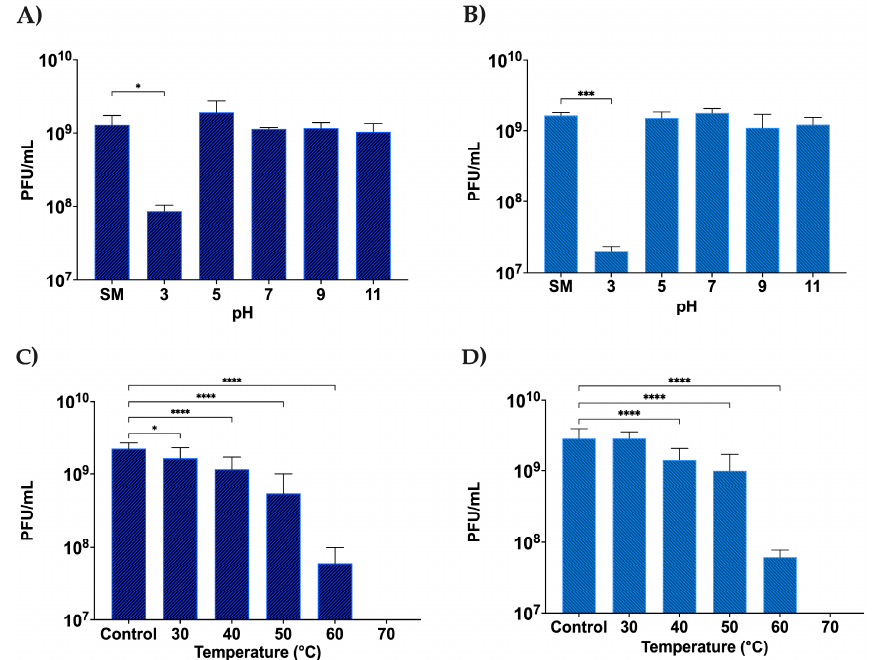
Figure 7. pH and temperature stability of DLP1 ( A , C ) and DLP2 ( B , D ) following an hour exposure. ( A ) pH stability of DLP1 compared to SM control (pH 7.4). ( B ) pH stability of DLP2 compared to SM control (pH 7.0). ( C ) DLP1 temperature stability compared to control (4 °C). ( D ) DLP2 tempera-